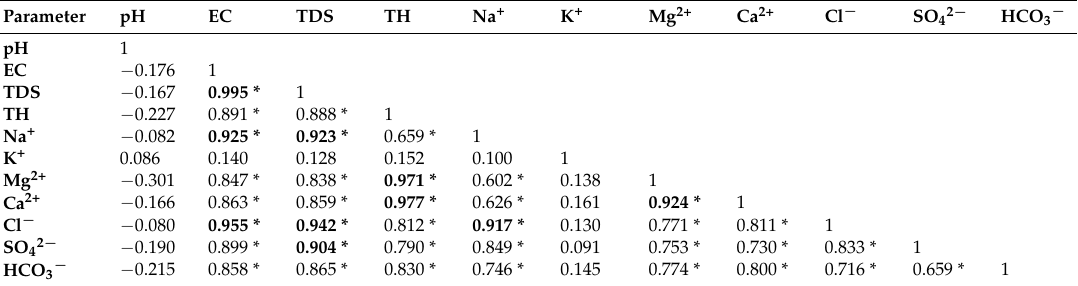
Table 4. Correlation coefficient matrix of major physiochemical